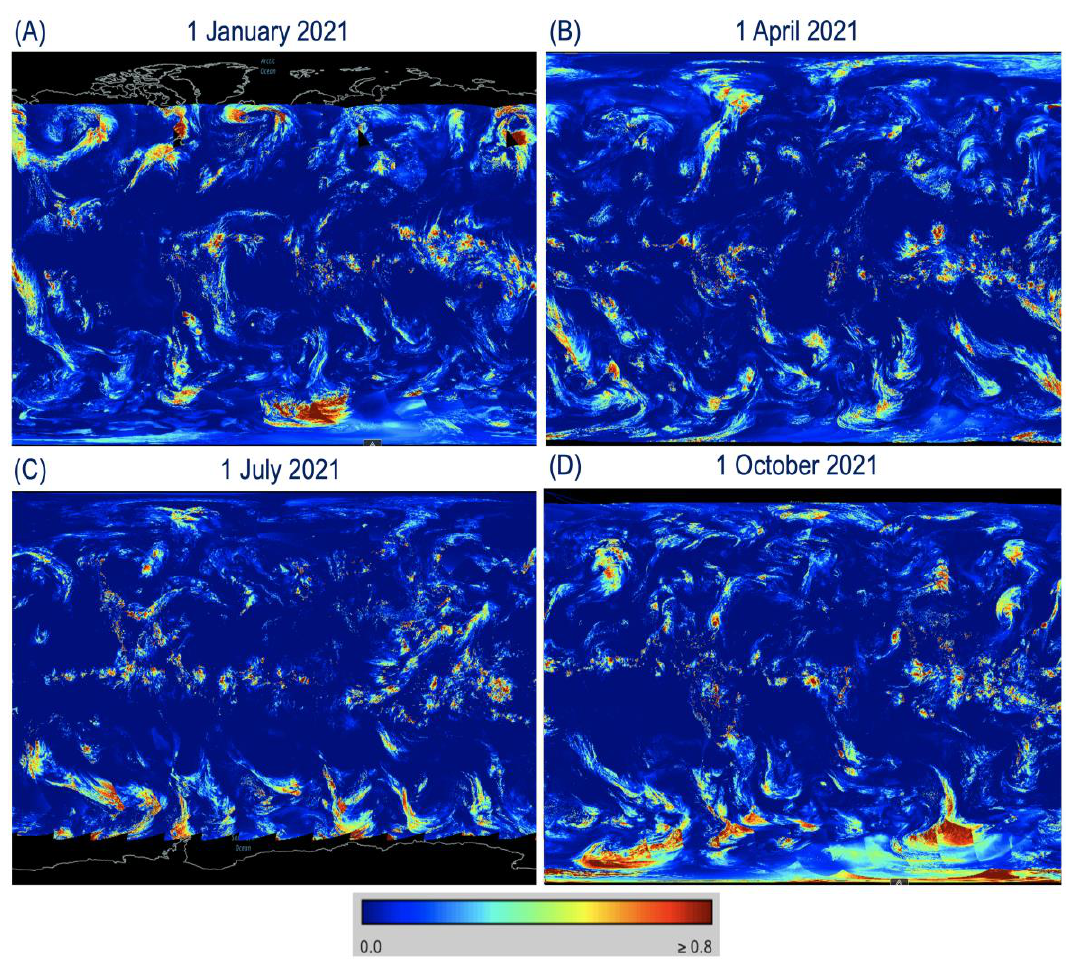
Figure 11. Global VIS-NIR cirrus reflectance images for 1 January ( A ), 1 April ( B ), 1 July ( C ), and 1 October ( D ) of 2021.